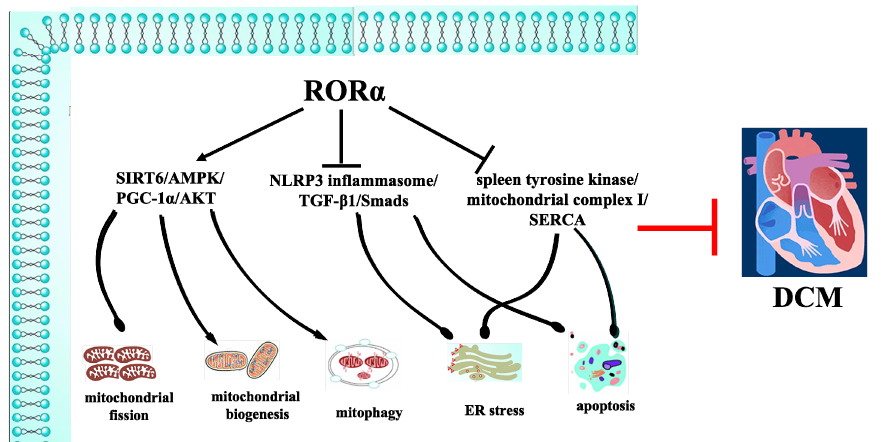
Figure 2. Molecular mechanisms and cellular pathways involved in ROR α ’s protective roles against DCM. ROR α agonist suppressed mitochondrial fission and promoted mitochondrial bio- genesis and mitophagy via SIRT6/AMPK/PGC-1 α /AKT axis to attenuate DCM. ROR α activation also ameliorated cardiac ER stress and apoptosis via inhibiting NLRP3 inflammasome activation and blocking TGF- β 1 /Smads signaling in DCM. ROR α activation also blocked spleen tyrosine kinase/mitochondrial complex I/SERCA axis to alleviate